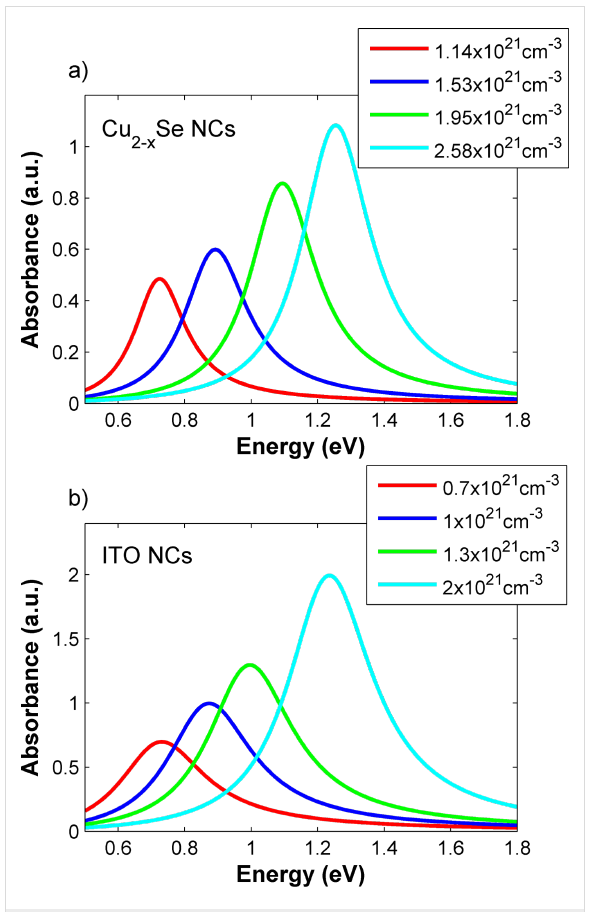
Figure 2: Illustration of the tunable optical properties of a) a Cu 2 − x Se NC dispersion and b) an ITO NC film as a function of carrier density N C = 1.14, 1.53, 1.95 and 2.58 × 10 21 cm − 3 (Cu 2 − x Se NCs) and N C = 0.7, 1, 1.3 and 2 × 10 21 cm − 3 (ITO NCs). The given absorption spectra are calculated according to a) Mie theory and b) the